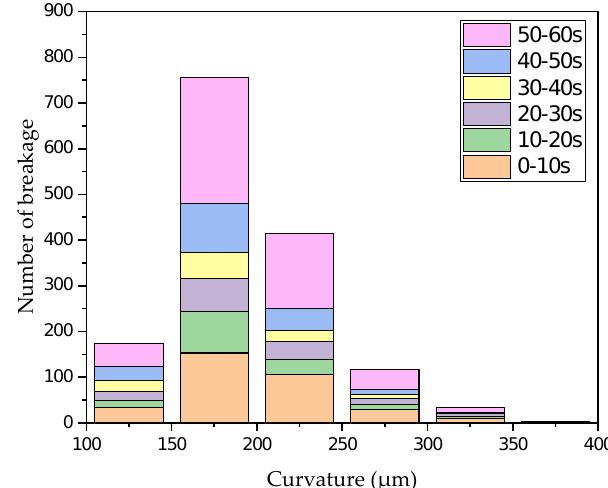
Figure 15. Breakage distribution over time of simulation results with fiber relaxation and probability breakage model applied.